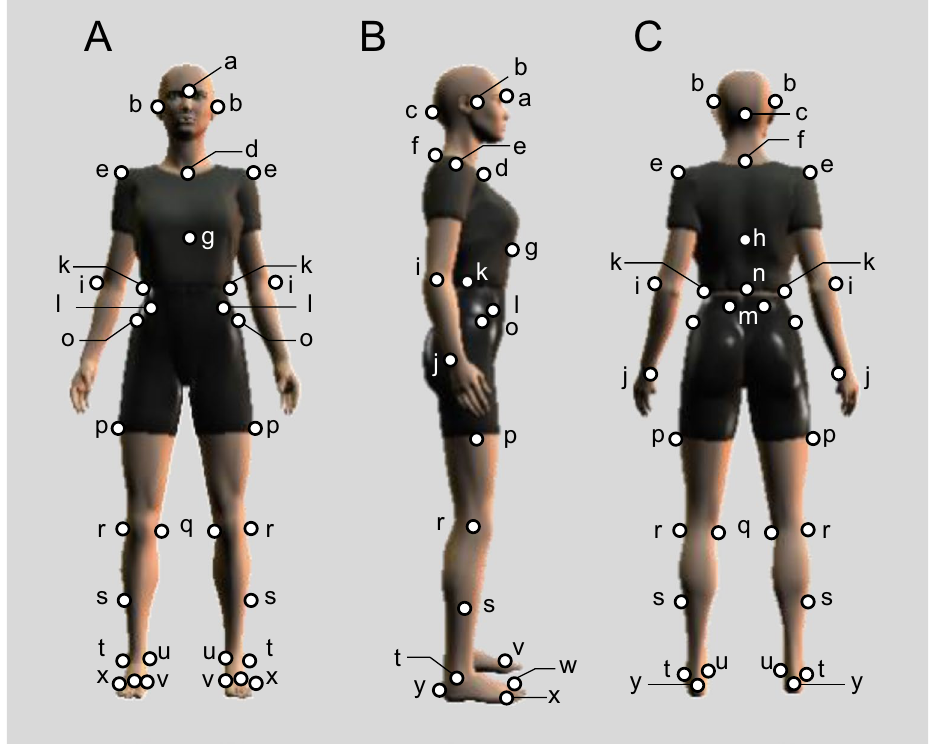
Figure 1. Forty-three reflective markers and trunk orthosis with joints providing resistive force. ( A ) Anterior view, ( B ) lateral view, and ( C ) posterior view. a, the bottom end of the center of the frontal bone; b, the articular tubercle; c, the external occipital protuberance; d, manubrium sterni; e, the acromion process; f, spinous process of the seventh cervical vertebra; g, xiphoid process; h, spinous process of the tenth thoracic vertebrae; i, the lateral epicondyle; j, ulnar styloid process; k, iliac crest; l, anterior superior iliac spine; m, posterior superior iliac spine; n, point between the fourth and fifth lumbar vertebrae; o, superior aspect of the greater